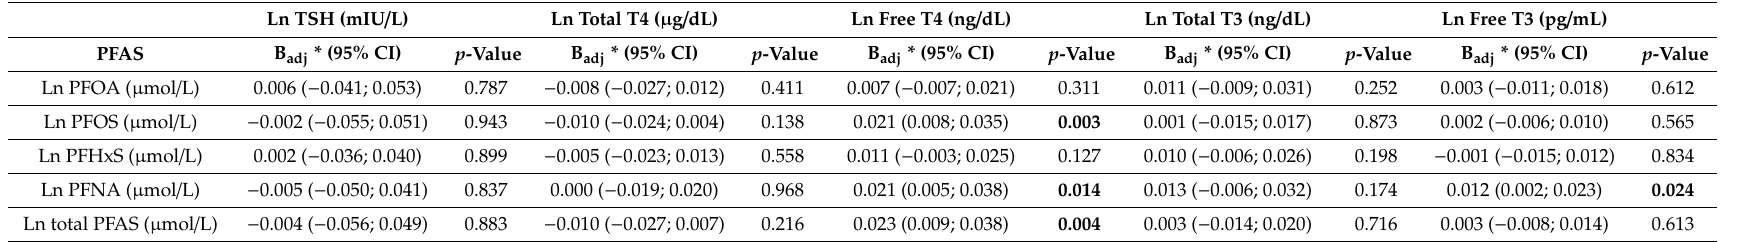
Table 2. Weighted adjusted * analysis model estimates for the association between PFAS and thyroid hormones ( n = 1325).